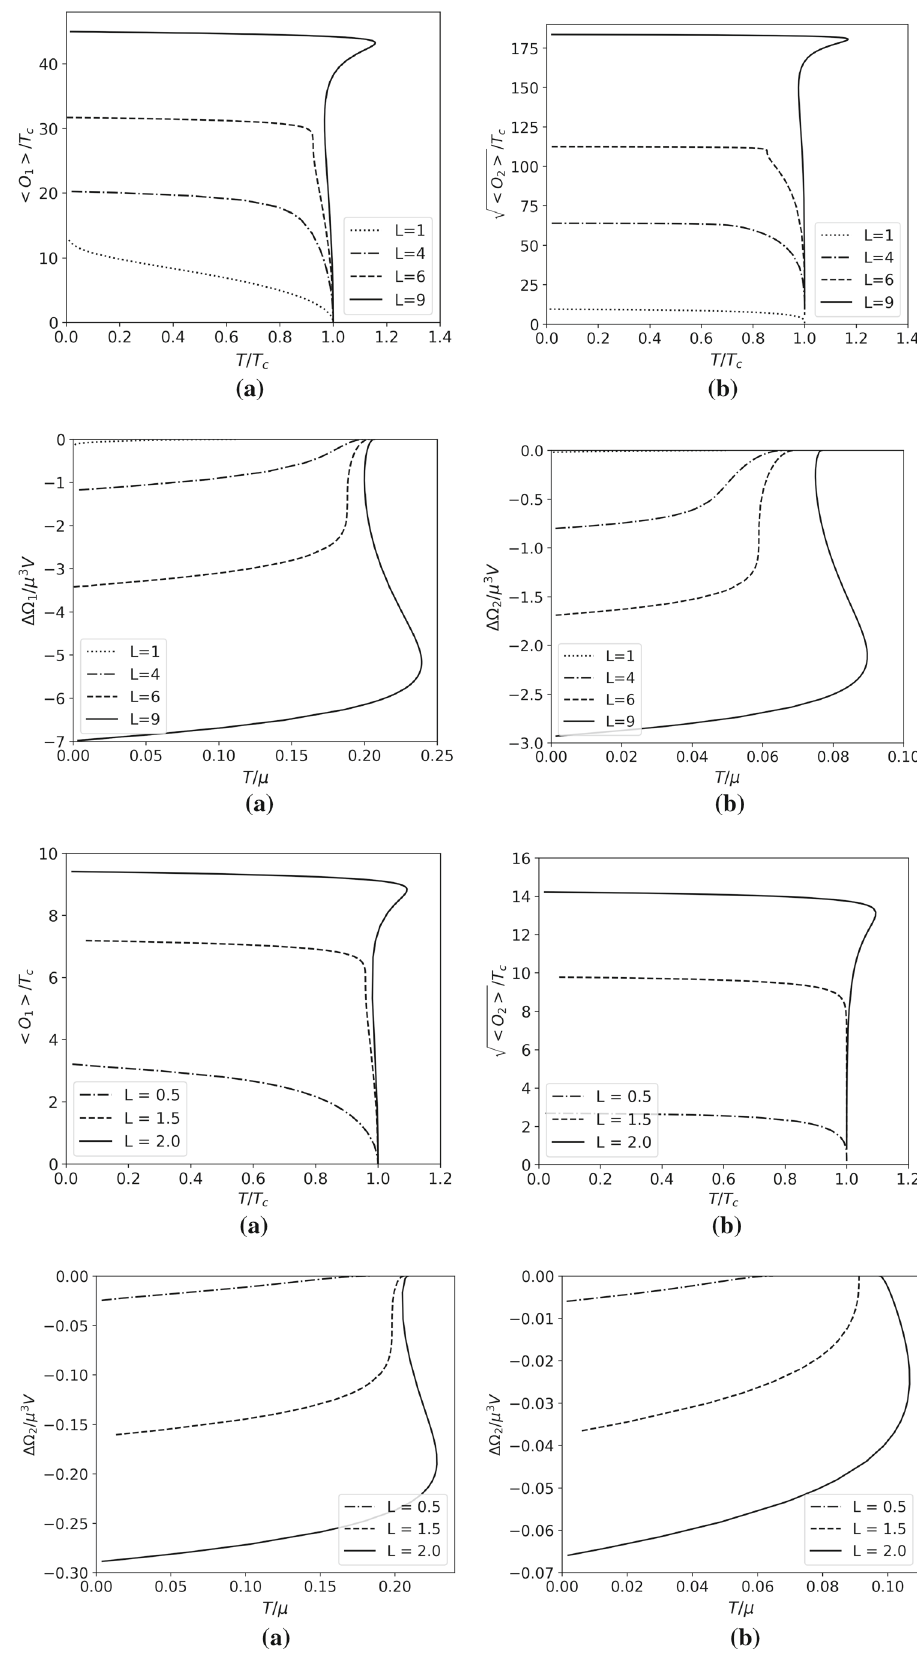
Fig. 2 For L < 6 the phase transitions are second order while for L ≥ 6 the first order phase transitions begin to exhibit for O 1 (up) and O 2 (down)